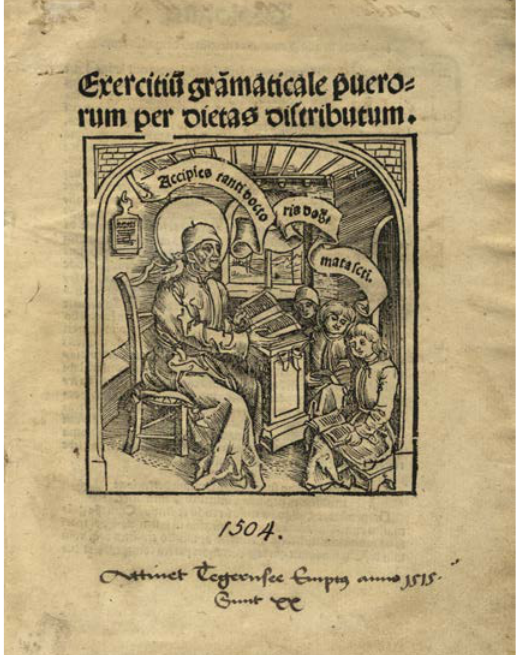
Figure 4 – Mural alphabet to teach reading, Exercitium grammaticale puerorum per dietas distributum